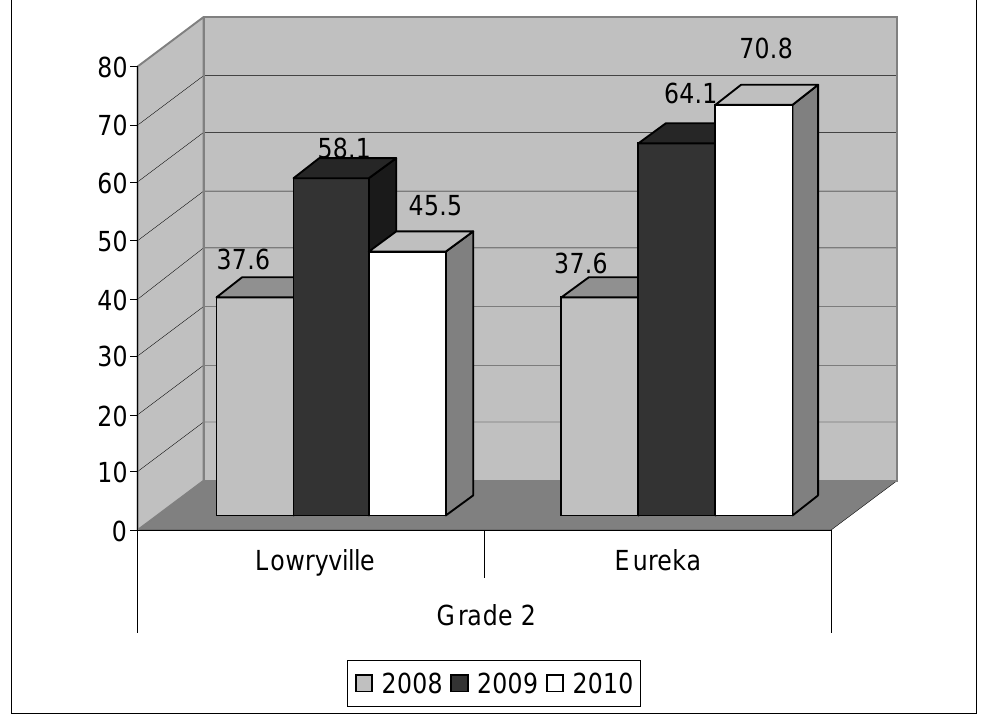
Figure 5 Mean Scholastic Scores of Grade Two Learners from 2008 to 2010